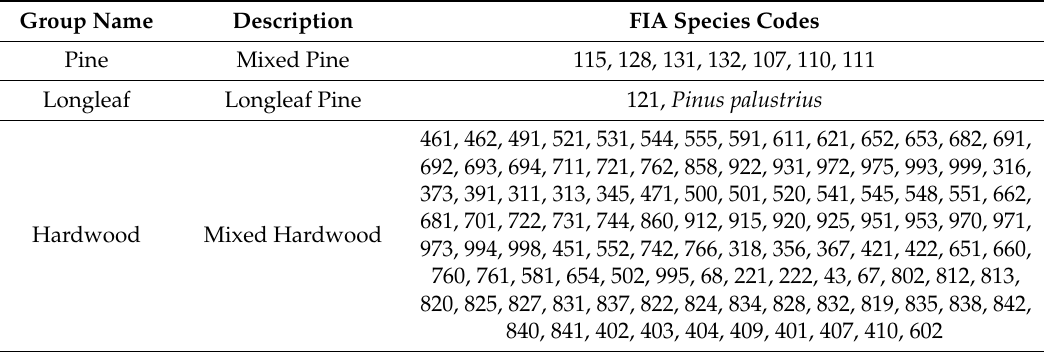
Table 1. Forest Inventory analysis (FIA) tree species groupings, description, and FIA species codes. Each code number corresponds to a tree species in the FIA protocol, which can be referenced online [8]. For this study, species were placed into three species groupings: Pine, Longleaf, and